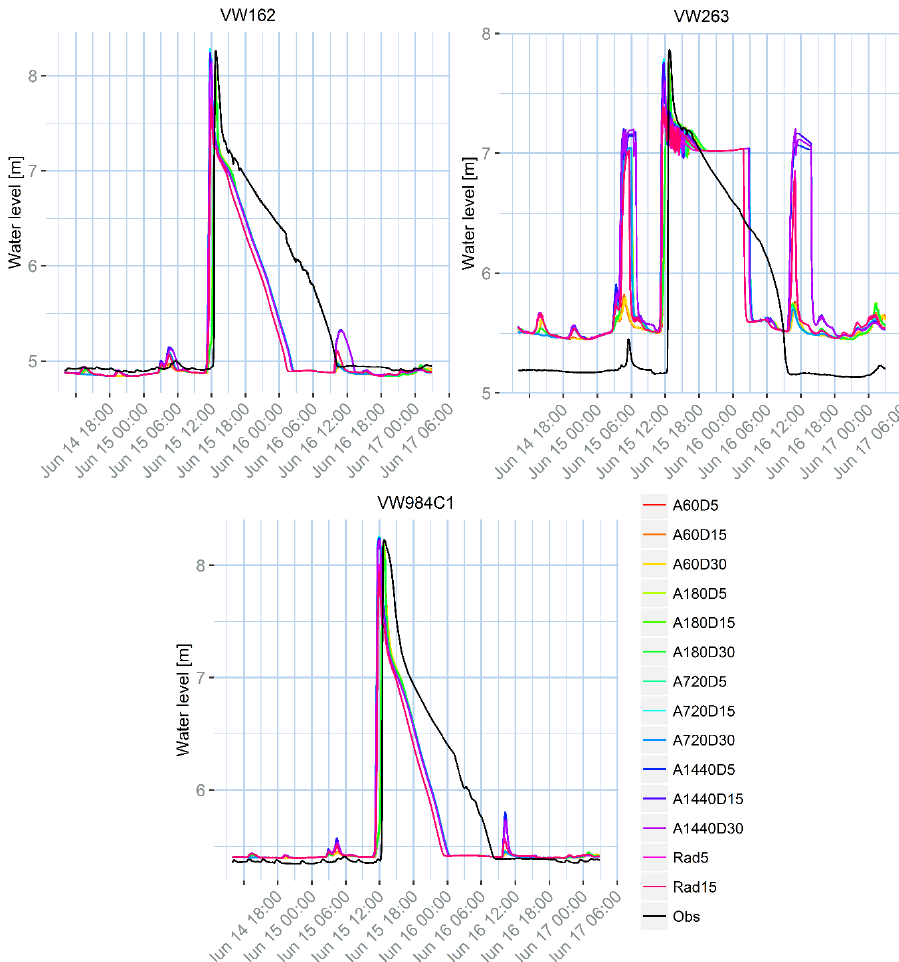
Figure 7. The 14 rainfall products are used as an input for the InfoWorks model and the results are compared to the water level observations in three distinct locations as reported in Figure 2. The names of the products describe the accumulation resolution (A) and the downscaling resolution (D) in minutes. Rad5 and Rad15 are the radar products at 5 and 15 min resolution, respectively, and Obs is the water level observation.